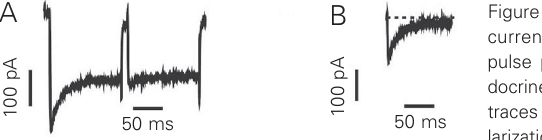
from a holding potential of -80 mV. The first current trace corresponds to the activation of both T-type (transient) and L-type Ca 2+ (sustained) currents. The second trace was re- corded after a brief time at -80 mV (10 ms) and then a return to 0 mV. The recorded current trace represents only L-type Ca 2+ current (sustained) because T-type channels were inactivated. B , Current trace obtained by digitally subtracting the current evoked after the pre-pulse from that before the pre-pulse as in A